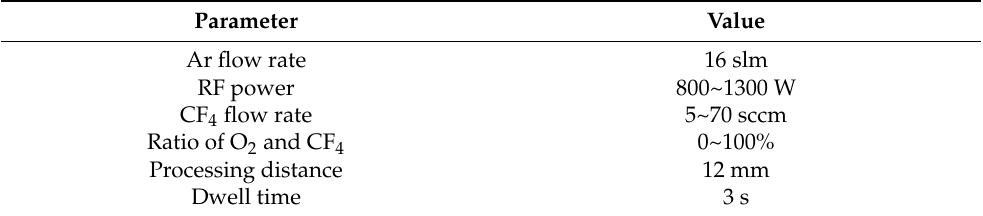
Table 1. Experimental parameters used for investigation of the removal